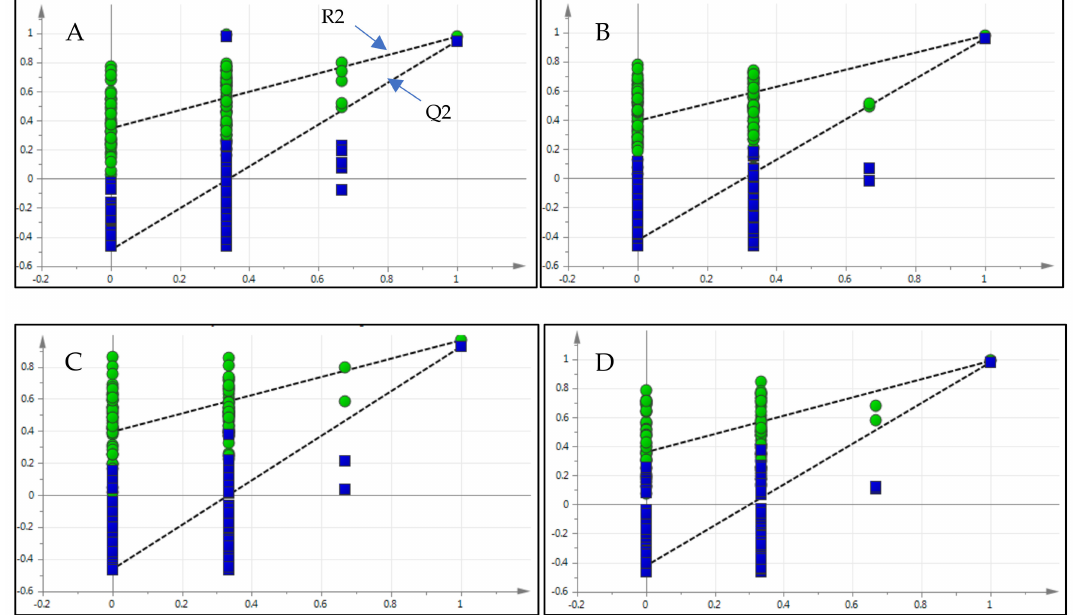
Figure 6. Graphs displaying the permutation tests for acacia ( A ); starfruit ( B ); gelam ( C ); and Apis ( D )